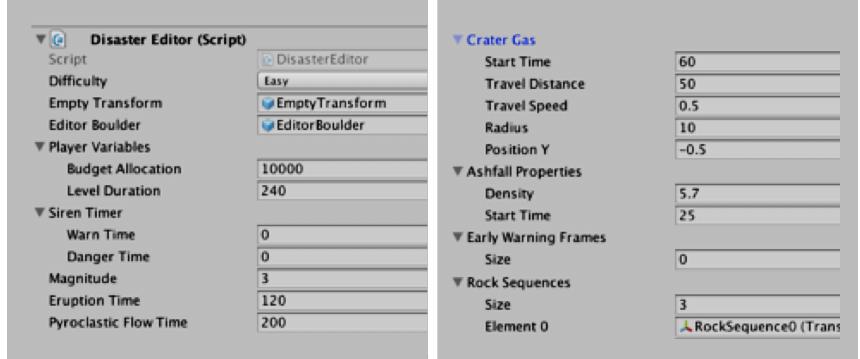
Figure 15. Detail of a menu used to input volcanic hazard variables in Earth Girl Volcano